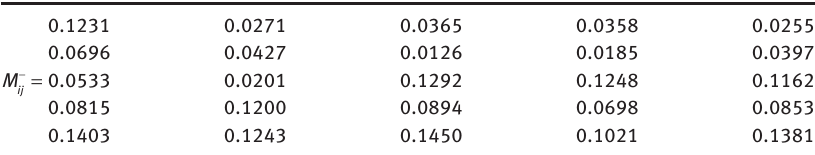
Table 15: The Negative-Ideal Separation Matrix.